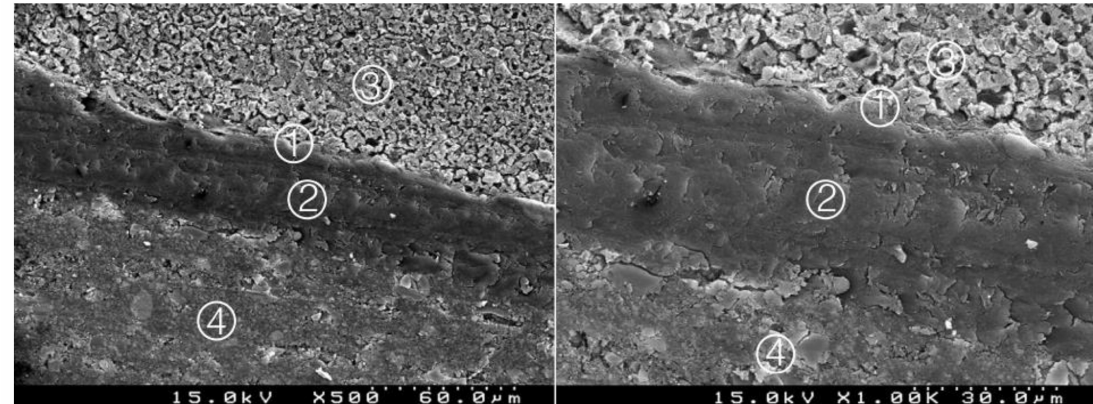
Figure 10. Group 8 (BiodentineU17): less interpenetration between the adhesive and the cement. A less deep interdiffusion layer is presented 1 (cid:13) between the adhesive in a thick layer 2 (cid:13) and the Biodentine TM 3 (cid:13) . Composite resin 4 (cid:13) (original magnification 500 × and 1000 × ).